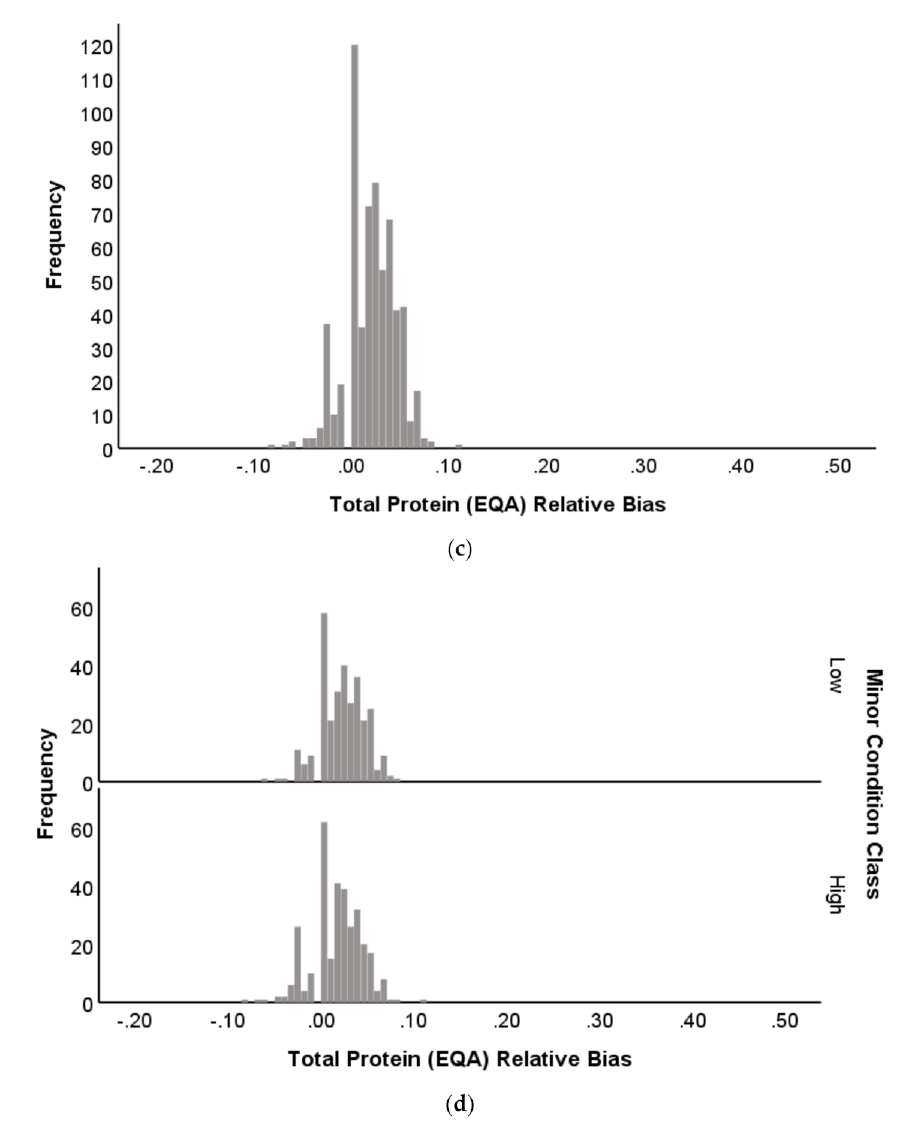
Figure 8. Frequency histograms for strong or poor EQA predictors of NATA Minor Condition Classes (High or Low)— ( Strong —( a , b )) GGT and ( Poor —( c , d )) Total Protein. The x -axis represents the distribution of cases across the range of analyte relative deviations